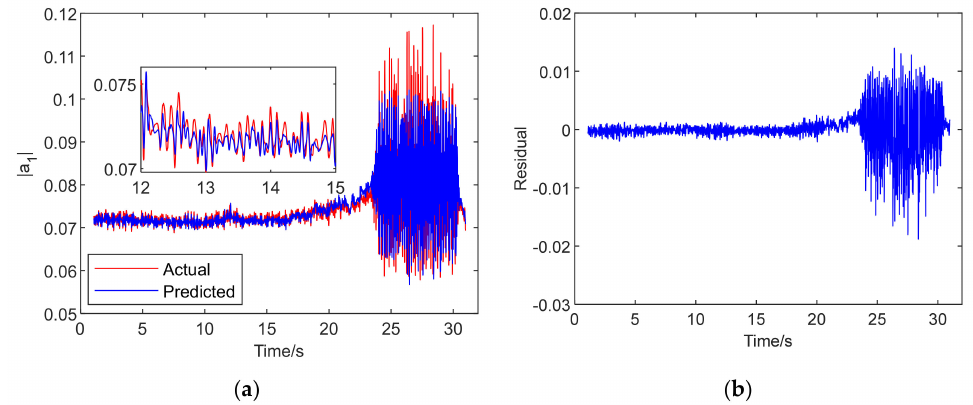
Figure 9. Result of Chaos–GD–RBF neural network model: ( a ) prediction; ( b ) residual.